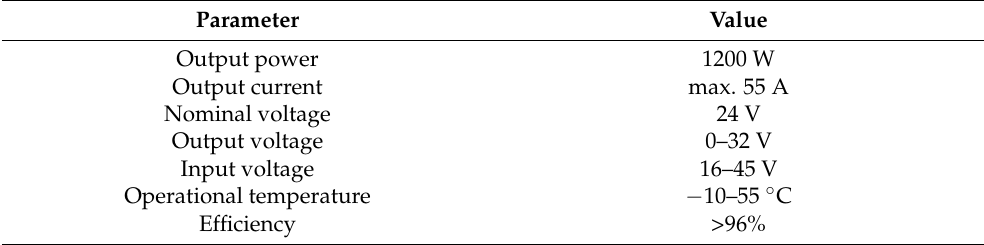
Table 2. Parameters of fuel DC/DC converter.